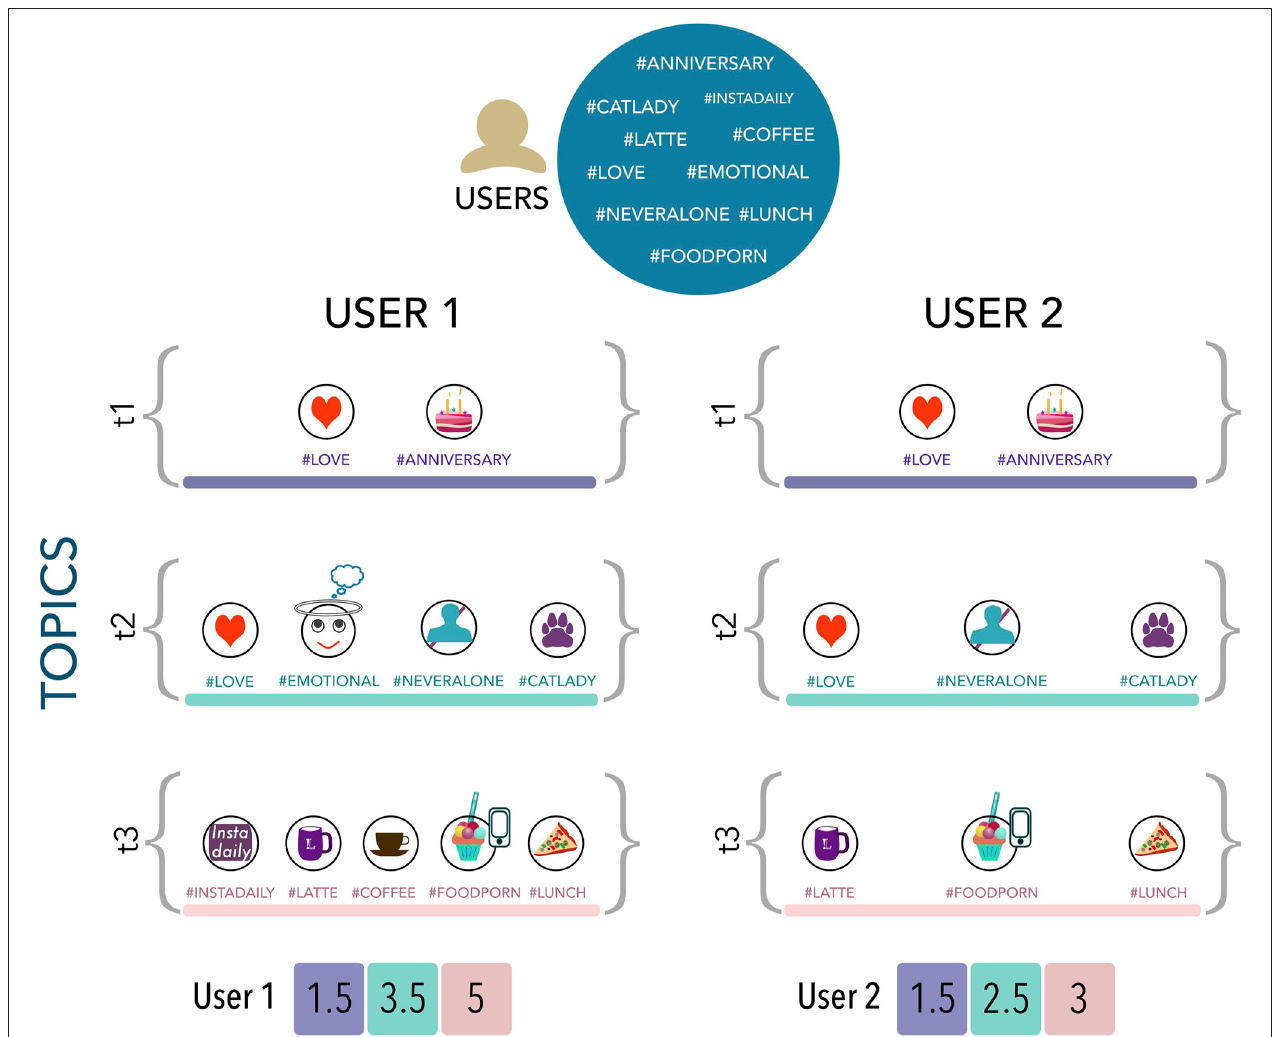
FIGURE 2 | Extraction of a user feature vector from hashtags in different topics. The figure shows an example of how the feature vector is computed for two users that are part of the datasets. Hashtags shown are a small sample of those contained in the whole dataset and have been selected only to illustrate the example